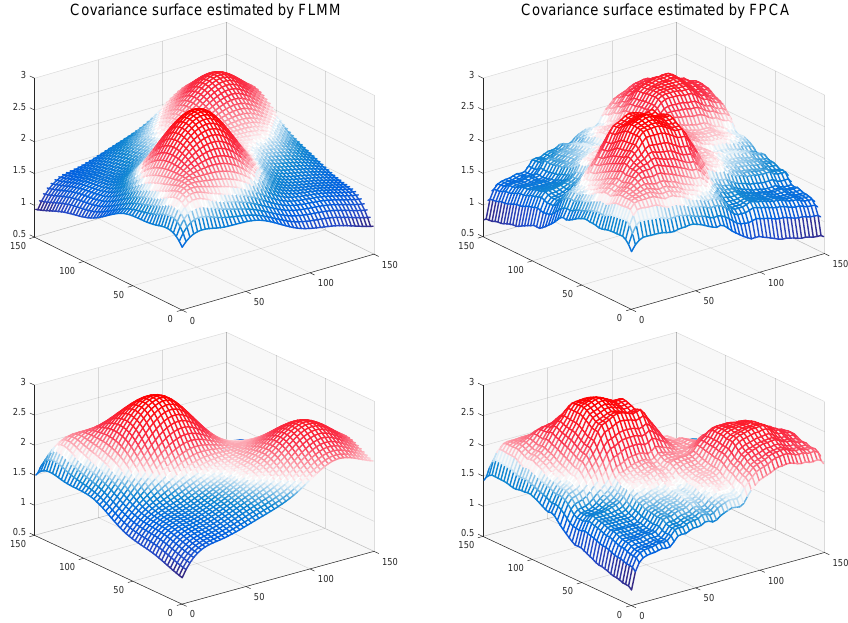
Figure 7. Fitted covariance surfaces via FPCA and proposed